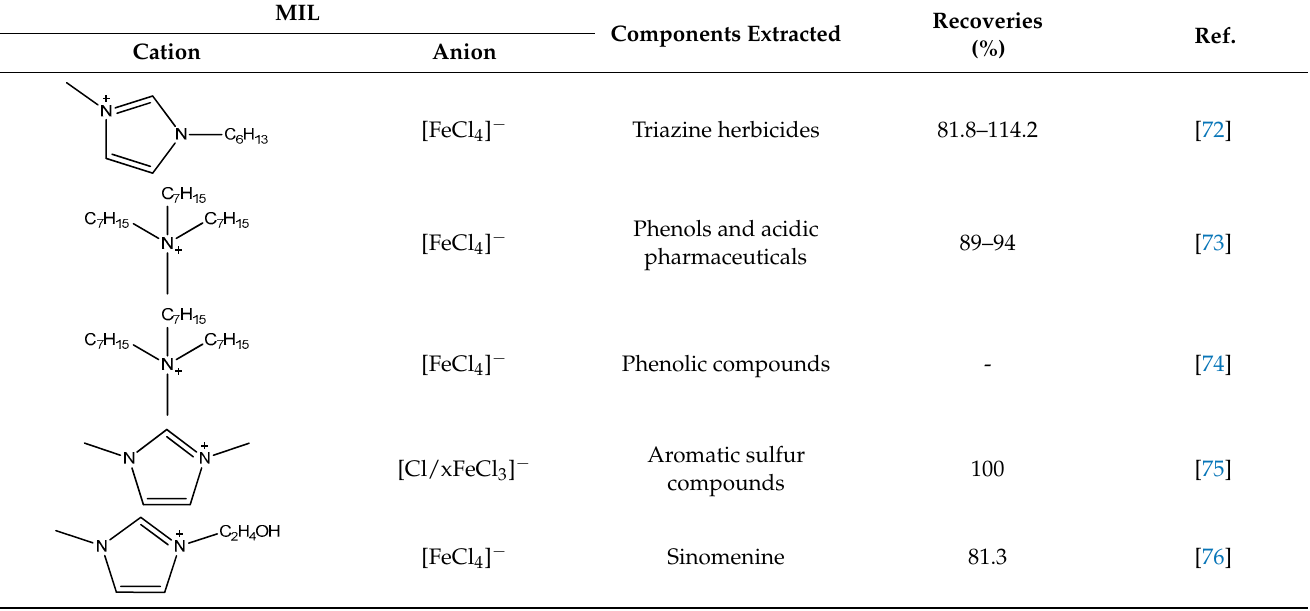
Table 1. Structures and extraction efficiencies of typical magnetic ILs.